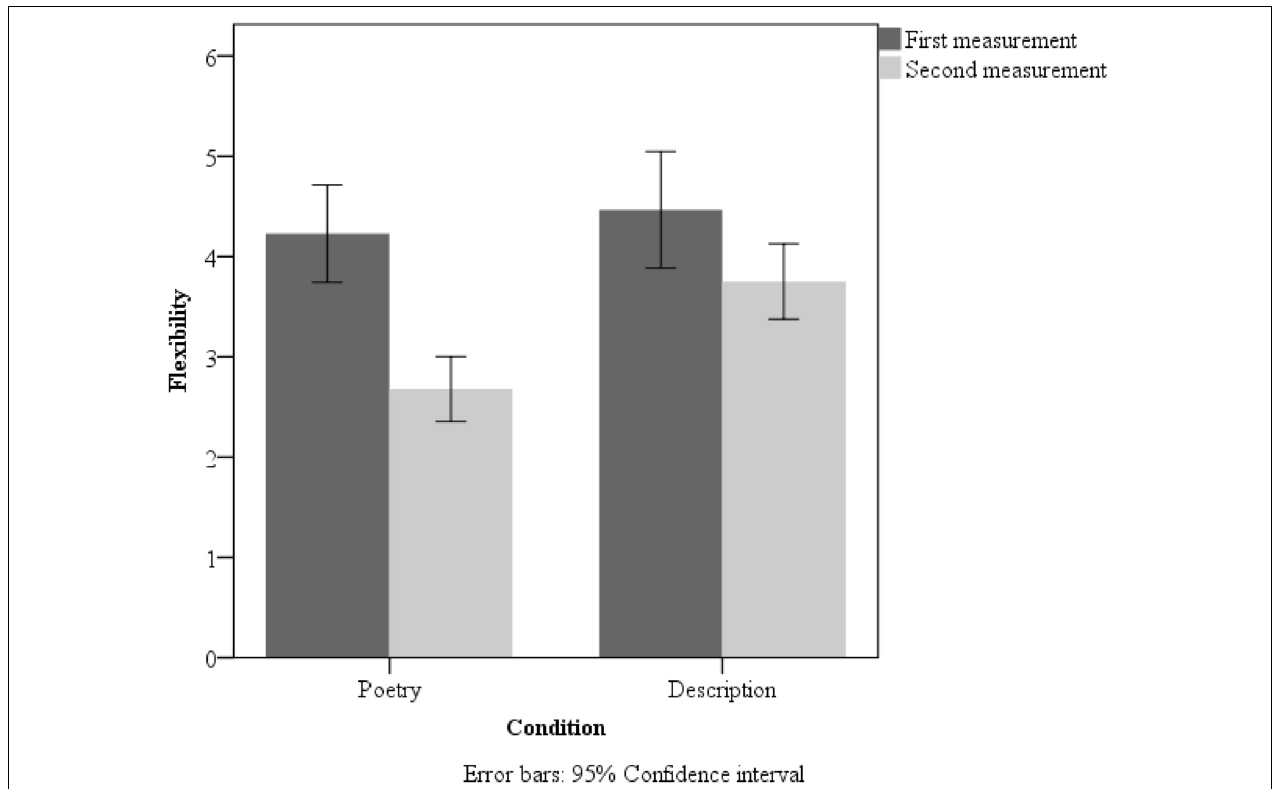
FIGURE 5 | Mean flexibility scores in the poetry-reading group and description-reading group in the first and second measurement in Study 2. Error bars: 95% Confidence